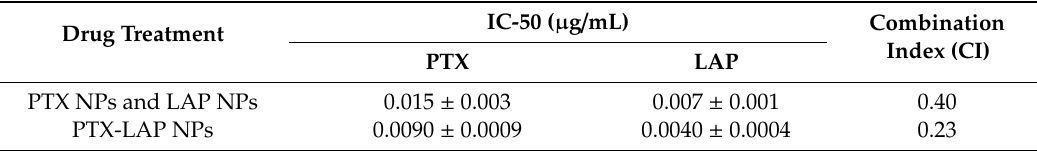
Table 5. IC-50 and combination index of paclitaxel–lapatinib nanoparticles (PTX–LAP NPs) (co-loaded) compared to simultaneous delivery of paclitaxel nanoparticles (PTX NPs) and lapatinib nanoparticles